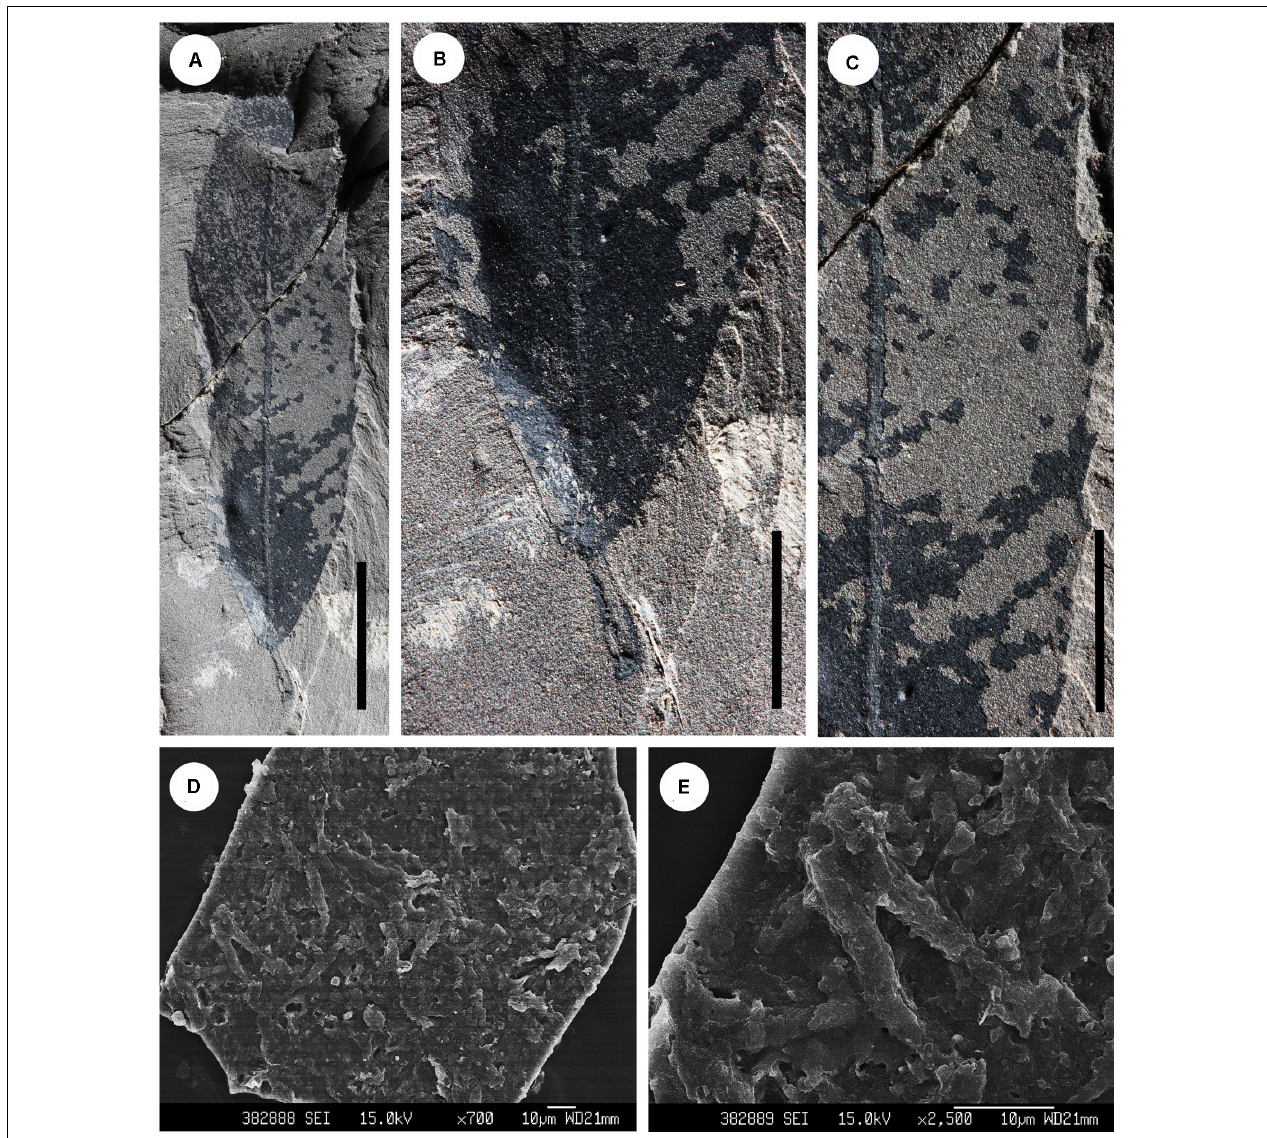
FIGURE 9 | Morphology of Lithocarpus changchangensis sp. nov. (A) Holotype. Specimen No. CC-1113, showing the leaf morphology; (B) enlargement of (A) , showing the base and petiole; (C) enlargement of (A) , showing the teeth and venation; (D) SEM image showing the rugose outer surface of leaf; (E) SEM image showing the appressed parallel tufts (APT) trichomes. Scale bars: 10 mm (A) ; 5 mm (B,C) .